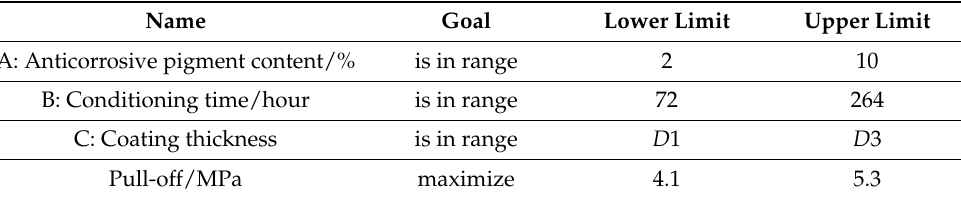
Table 7. Defined limitations for optimization of parameters.